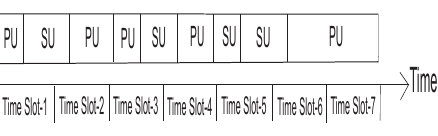
Figure 1. Considered TDMA cognitive radio network.